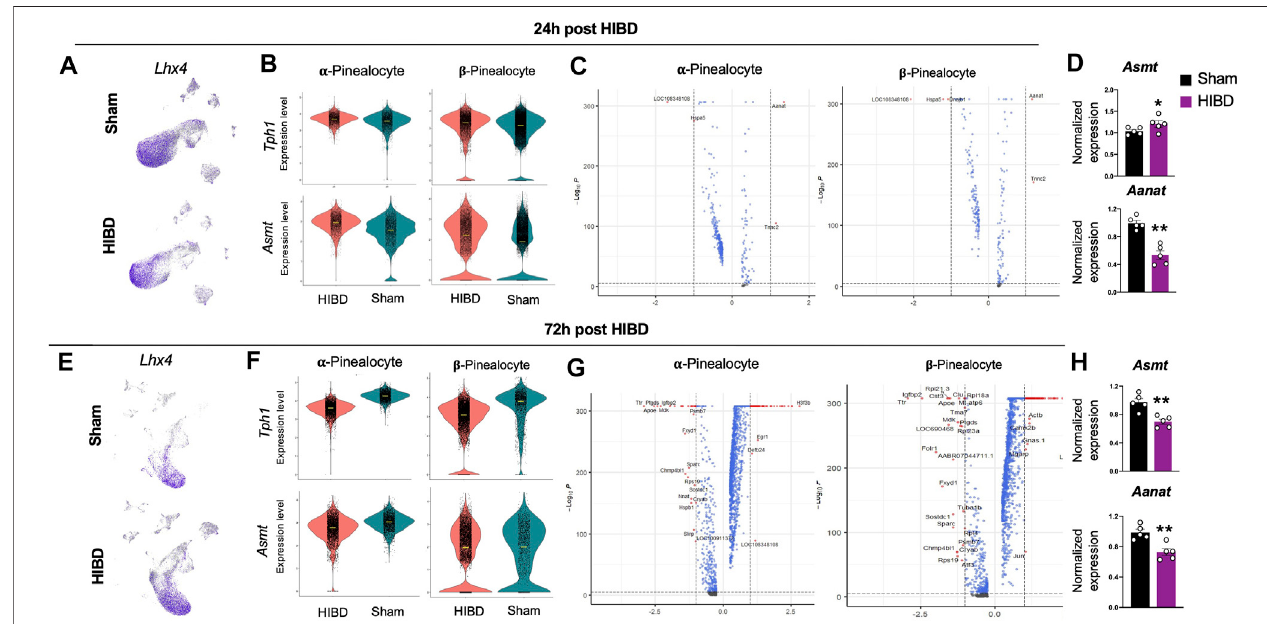
FIGURE4| Transcriptomechangesinpinealocytesubtypes post neonatal HIBD (A,E) Feature plotsofapinealocytespeci fi ctranscriptional factor( Lhx4 ) overtotal pineal populations at 24 h (A) or 72 h (E) post sham or neonatal HIBD, respectively (B,F) Violin plots showing expression differences of characteristic genes ( Tph1 and Asmt ) at 24 h (B) or 72 h (F) post sham or neonatal HIBD, respectively (C,G) Volcano plots highlighting genes with signi fi cant expressional changes between sham and HIBDinbothsubtypesat24 h (C) or72 h (G) postshamorneonatalHIBD,respectively.Reddots: < adjusted p value(0.0001)and > 2fold;Bluedots: < adjusted p value (0.0001) with < 2 fold; Gray dots: no signi fi cance (D,H) Quanti fi cation of pineal RNA expression of Asmt and Aanat at 24 h (D) or 72 h (H) post sham or neonatal HIBD, respectively. n = 5,5 for sham and HIBD animals, fold changes of RNA expression were fi rst normalized to those of GAPDH , and then to those in the sham. Student ’ s t test, ** or *, p < 0.01 or